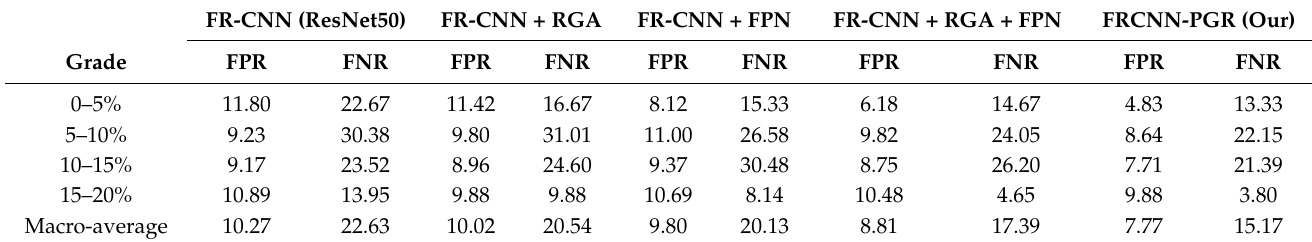
Table 4. The results of FPR and FNR (unit: